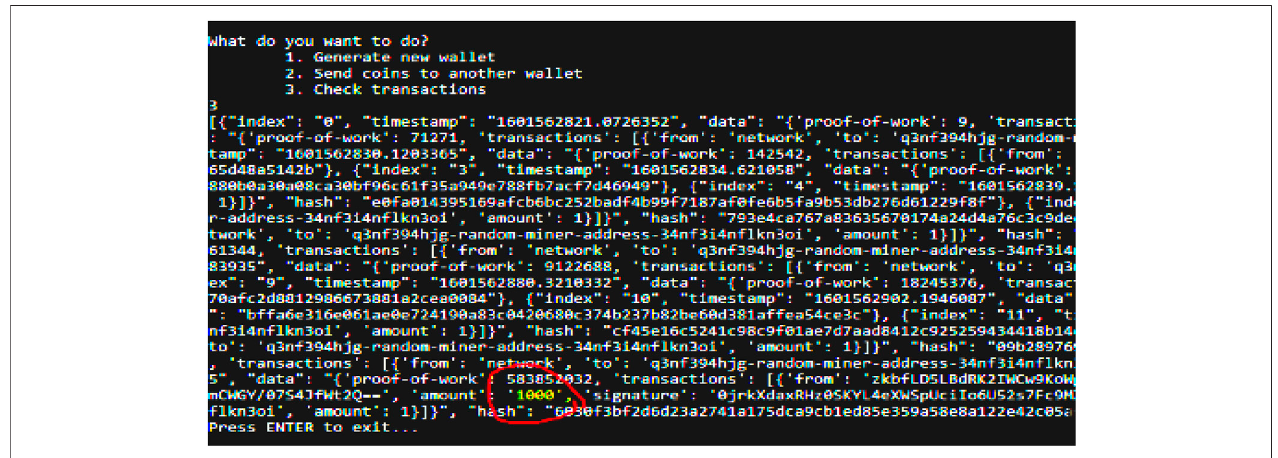
FIGURE 14 | View Transactions.